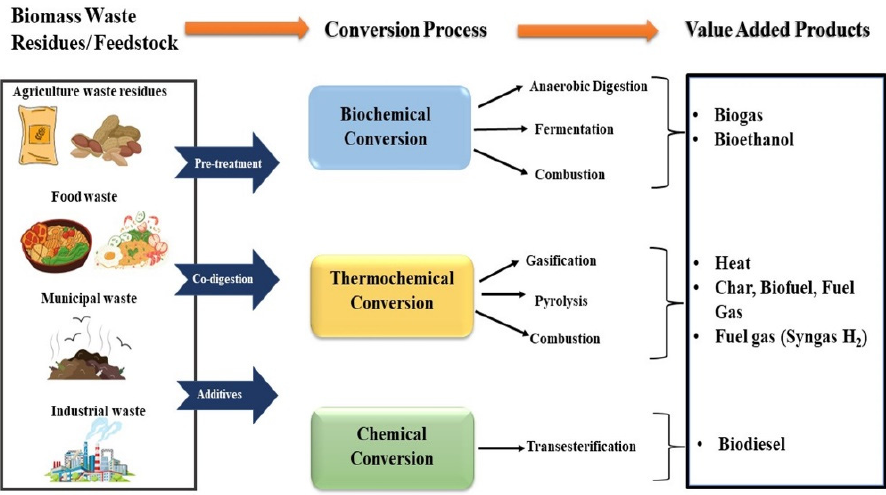
Figure 4. Pictorial illustration of the biomass conversion process to obtain enriched